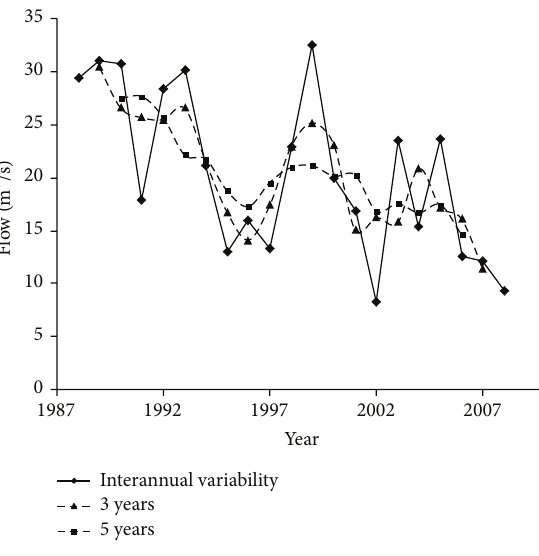
Figure 3: Trend of the variation of annual runoff.